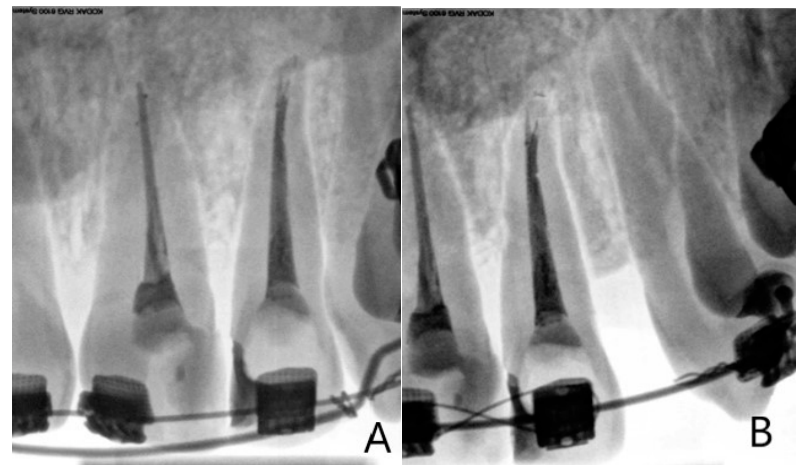
Figure 7. Intraoral periapical radiographs demonstrating the changes in periodontal ligament space width (Kodak software negative/positive mode to enhance subtle periodontal space changes. ( A ) Baseline intraoral periapical radiograph taken at the first appointment. ( B ) Intraoral periapical radiograph taken at the third appointment during treatment with FOAs. Evident widening of periodontal ligament space of distal/lateral aspect.